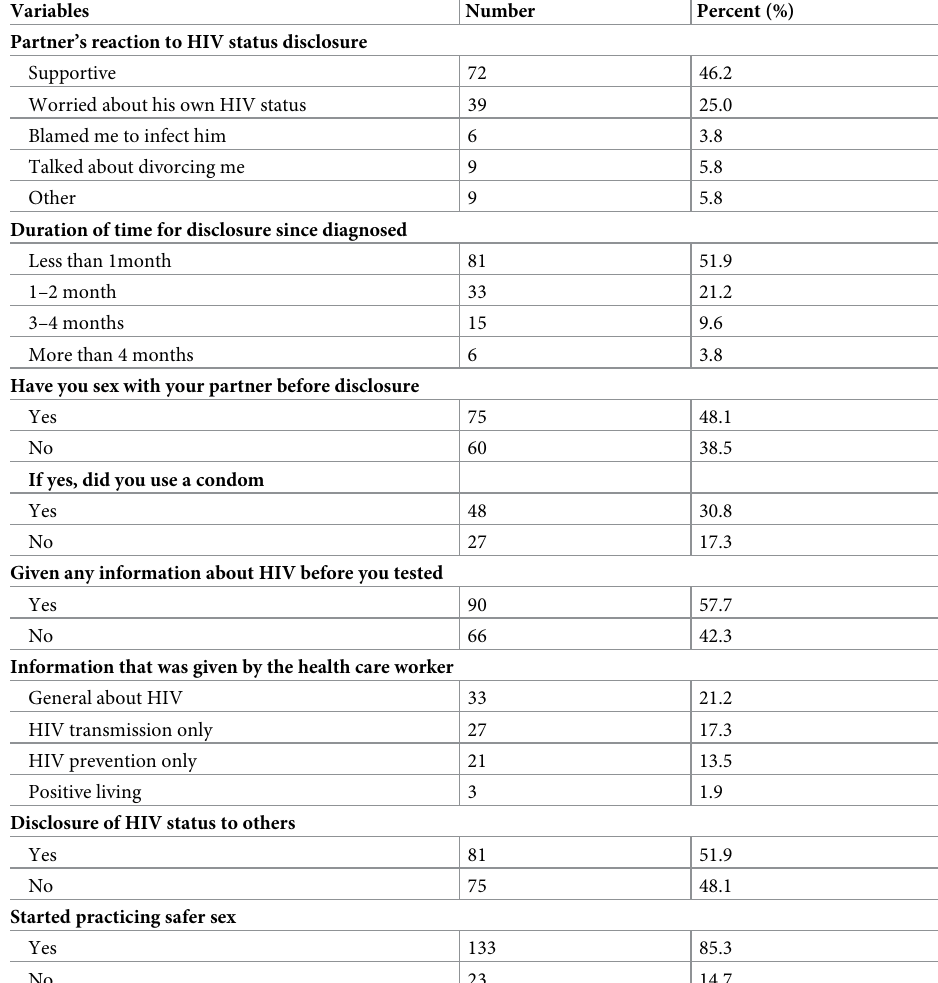
Table 2. Seropositive HIV status disclosure experience by HIV-positive pregnant women attendant ANC service in public health facilities in Dire Dawa, Ethiopia, 2020, (n =